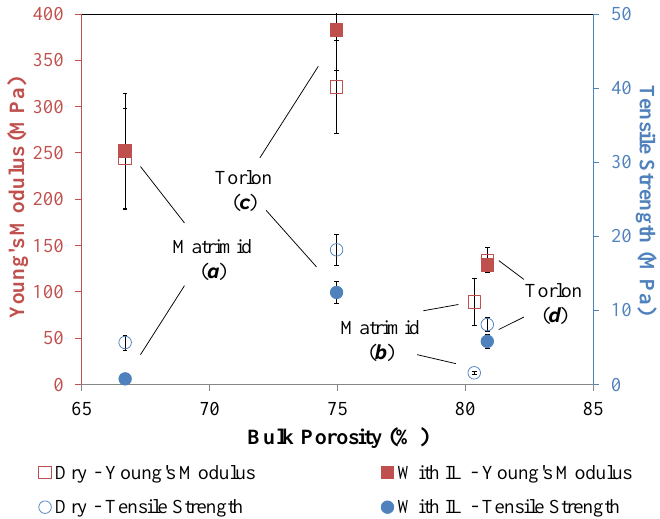
Figure 5. Young’s modulus and ultimate tensile strength of dry hollow fibers and fibers saturated in [C 6 mim][Tf 2 N] at 30 °C.